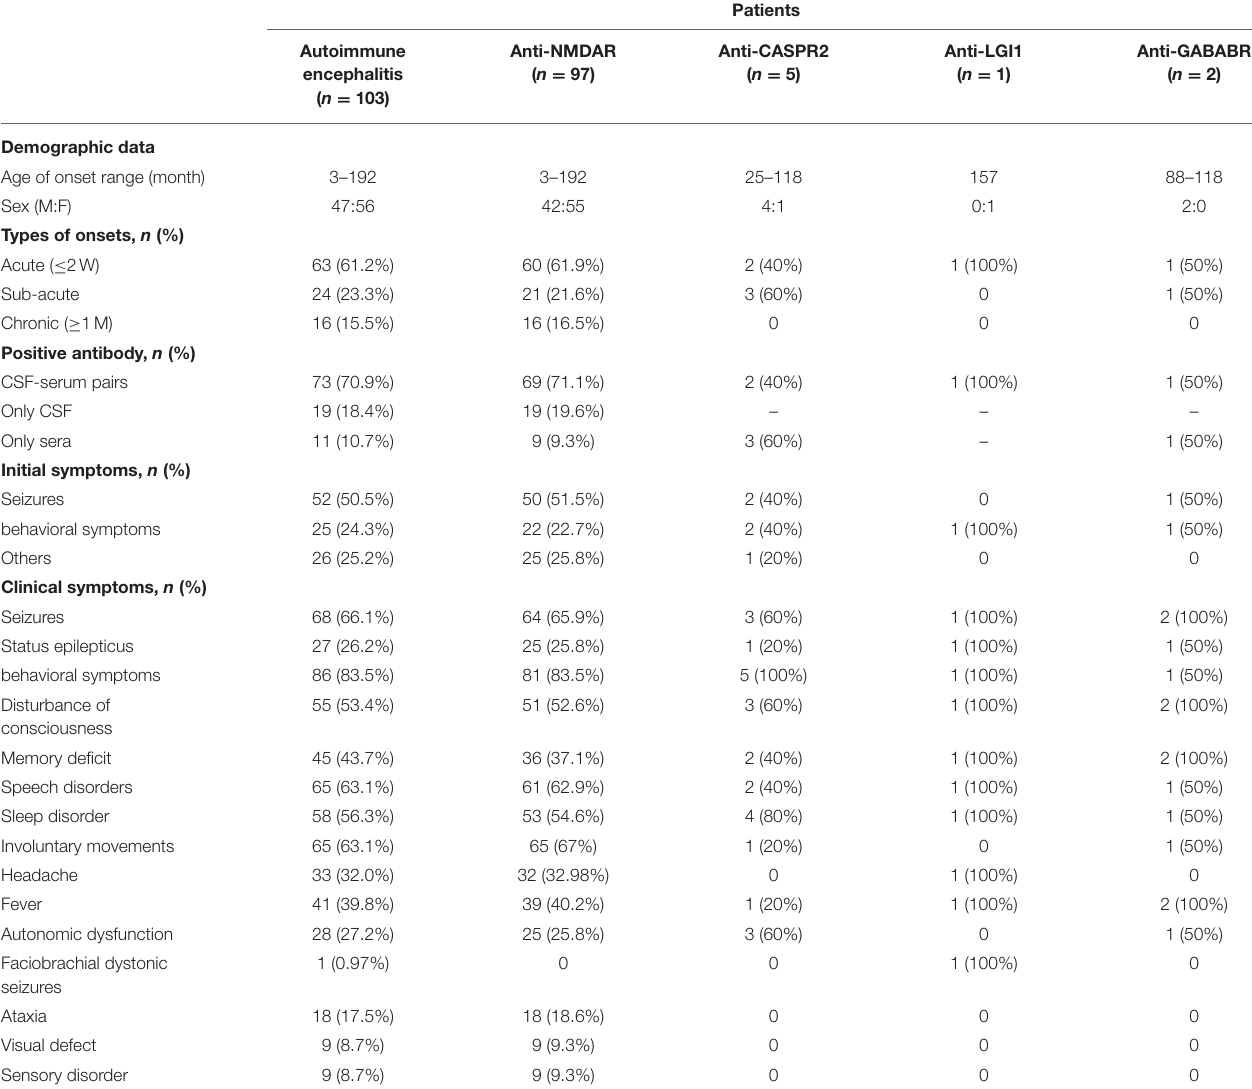
TABLE 1 | Demographic data and clinical features in AE patients.